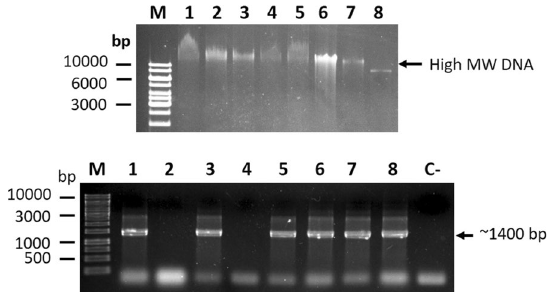
Fig. 3 A stained agarose gels show the verification of different selected colonies upon transformation of pFB-ie2-GFP-ie1-phr plasmid into DH10β cells carrying Splibac. The upper agarose gel shows High Molecular Weight (HMW) genomic DNA isolated from 8 screened colonies. The lower agarose gel shows amplification of phr gene ORF of eight selected colonies using phr-F and phr-R primers. M: 1 kbp DNA ladder. Arrow shows a clear band of 1.4 kbp corresponding to the phr gene construct and location of primer pairs used for verifica- tion of the recombinant virus is represented in Fig. 2. As shown in Fig. 3 (upper gel), high molecular weight DNA